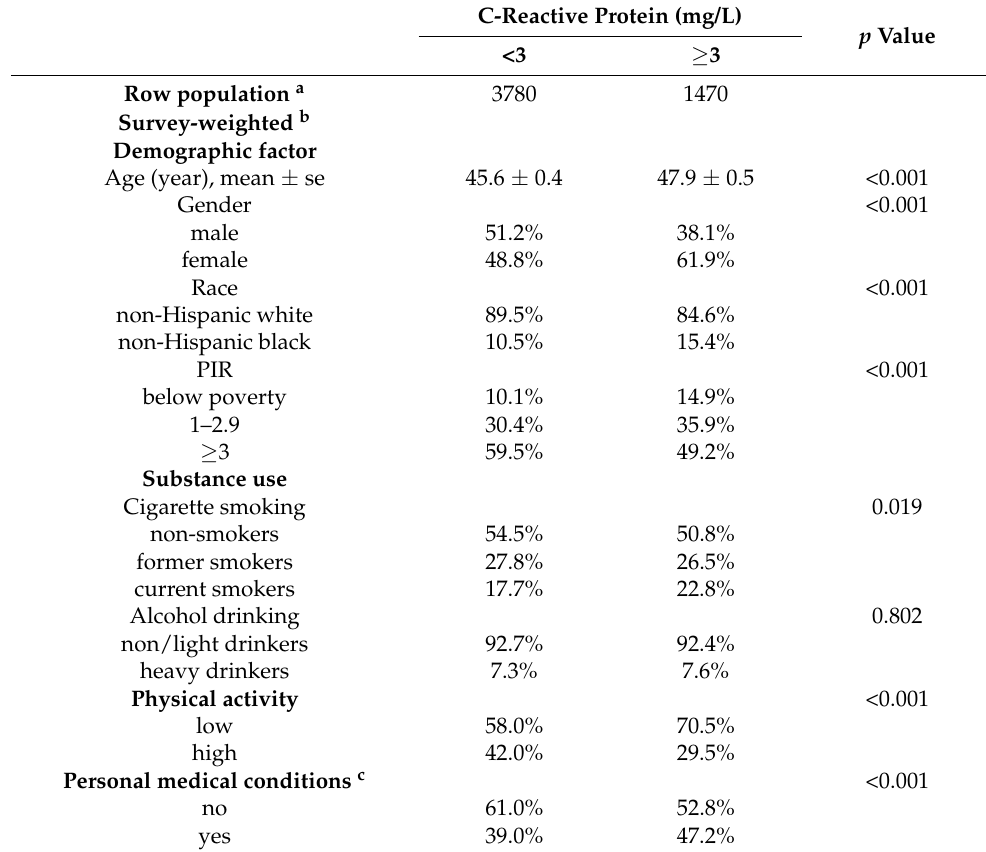
Table 1. Distribution of demographic, substance use, lifestyle pattern, disease history, and examina- tions between the level of C-reactive protein <3 and ≥ 3 mg/L. C-Reactive Protein (mg/L) p Value <3 ≥ 3 Row population a 3780